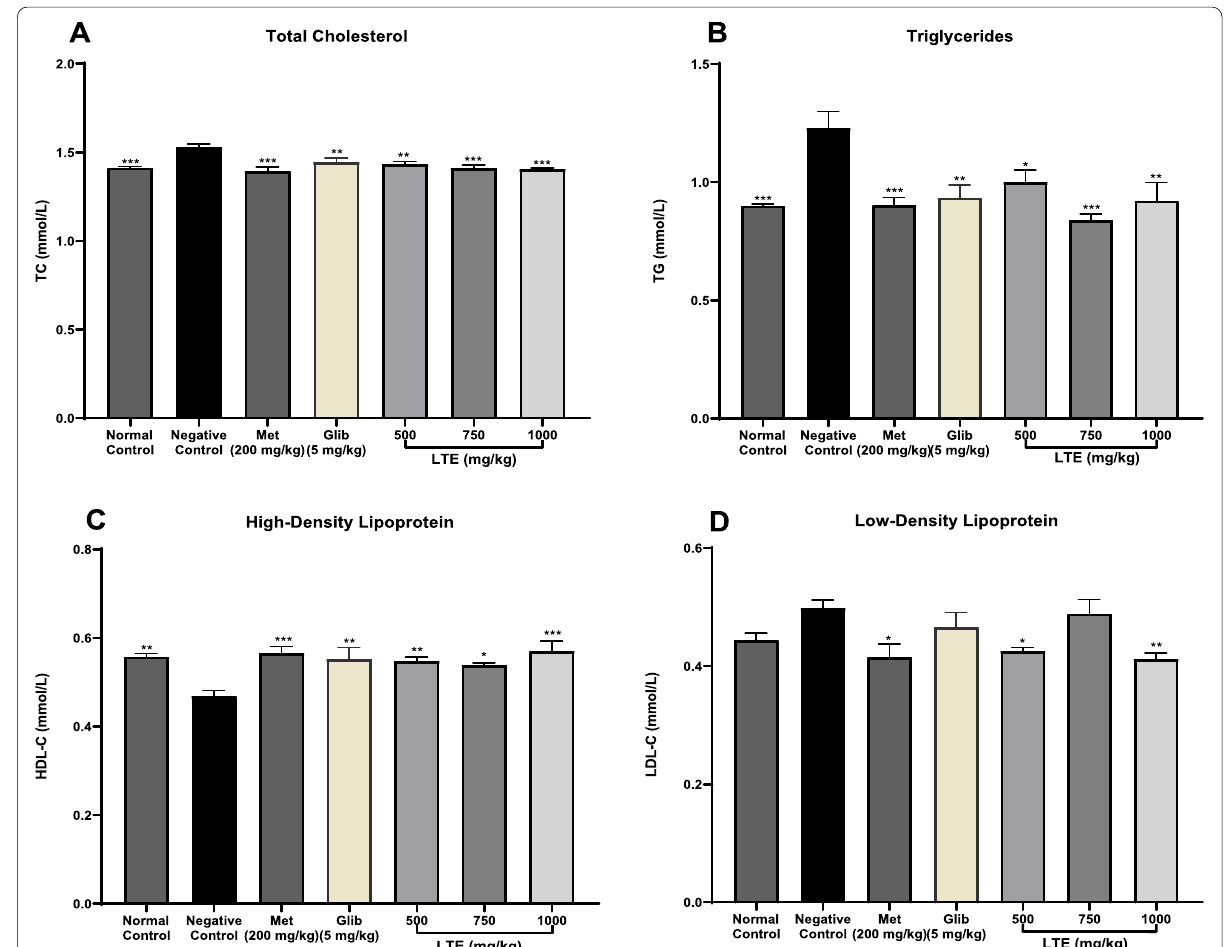
Fig. 4 Effects of LTE on serum lipid profile. Values were expressed as mean Dunnett’s multiple comparisons test. * represents statistical significance at p < 0.05 vs. the negative